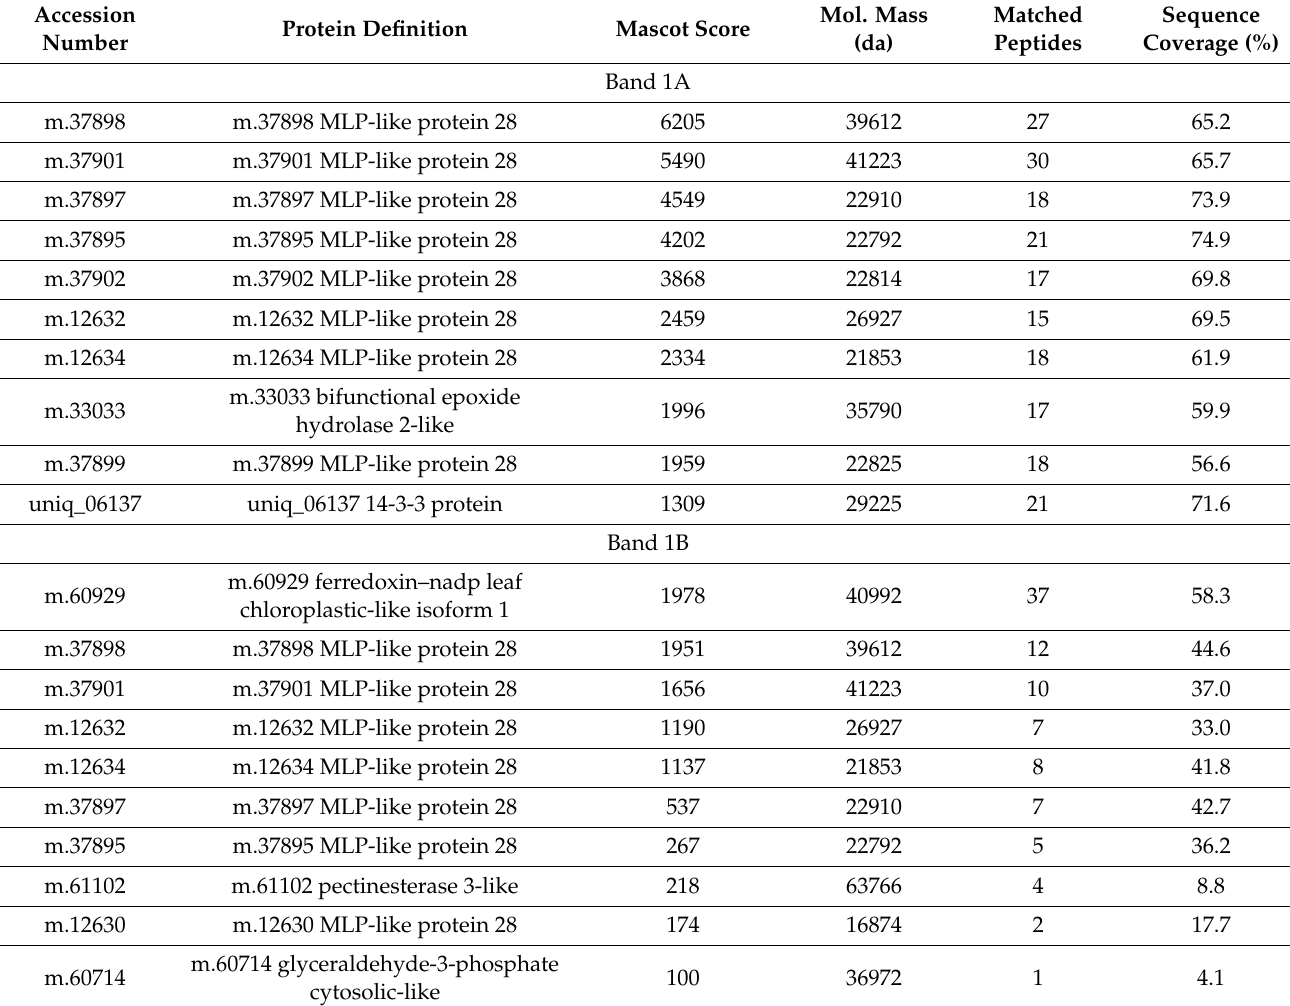
Table 1. MS/MS results of protein bands cut from an in-gel DNase assay zymography gel (Figure 2, Band 1A) and a silver-stained SDS-PAGE gel (Figure 2, Band 1B) after electrophoretic separation of protein fractions isolated from whole plant extract. The main constituent of the fractions was